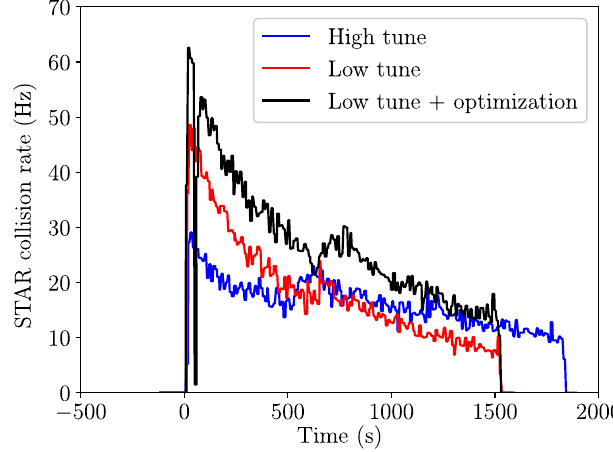
FIG. 7. The experimental collision rates for stores at 3 . 85 GeV = nucleon with different fractional betatron tunes. The blue data were taken with fractional tunes of 0.23, when the electron cooling efficiency was higher. The red data correspond to fractional tunes of 0.12, when the cooling efficiency was reduced but the ion beam lifetime was increased. The black data were taken after fine betatron tune adjustments and with smaller electron beam currents, further improving the ion beam lifetime with less heating.